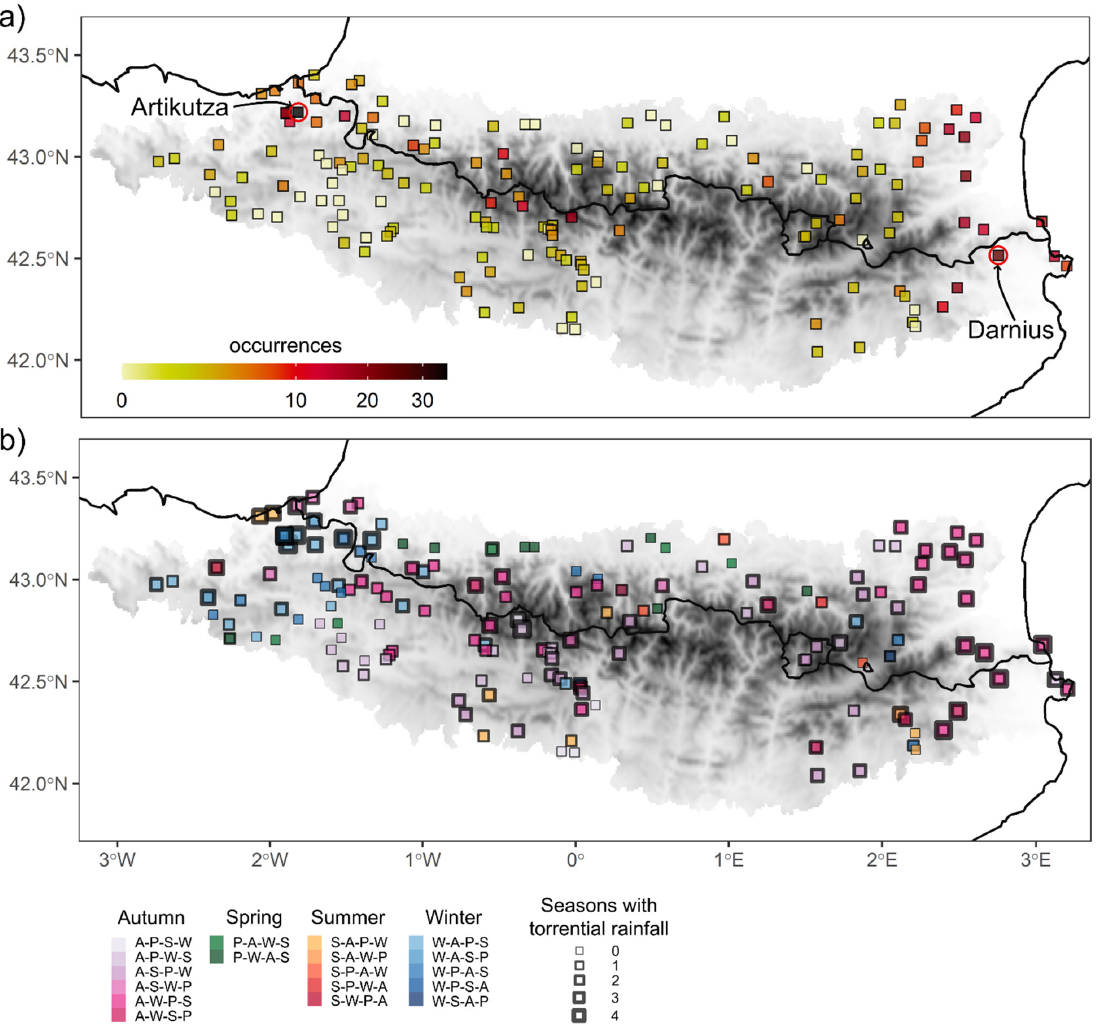
Figure 3. ( a ) Number of days with torrential rainfall for the 1981–2015 period. Location of Artikutza and Darnius rain gauges, which present the greatest number of torrential events (they are, therefore, used to calculate the backward trajectories with the Hysplit model in Section 3.4). ( b ) Seasonal torrential regimes in the Pyrenees: A (autumn), P (spring), S (summer), and W (winter). The border thickness of the box indicates the number of seasons with torrential rainfall, and the boxes with the thickest line, therefore, correspond to weather stations that recorded at least one event in winter as well as in spring, summer and autumn.